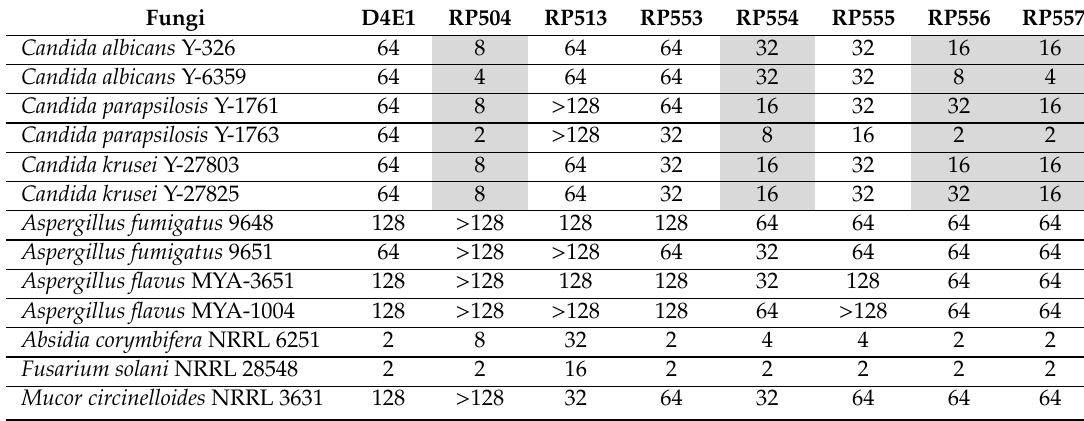
Table 1. Minimum Inhibitory Concentrations (MICs, µ g / mL) against Fungal Strains.